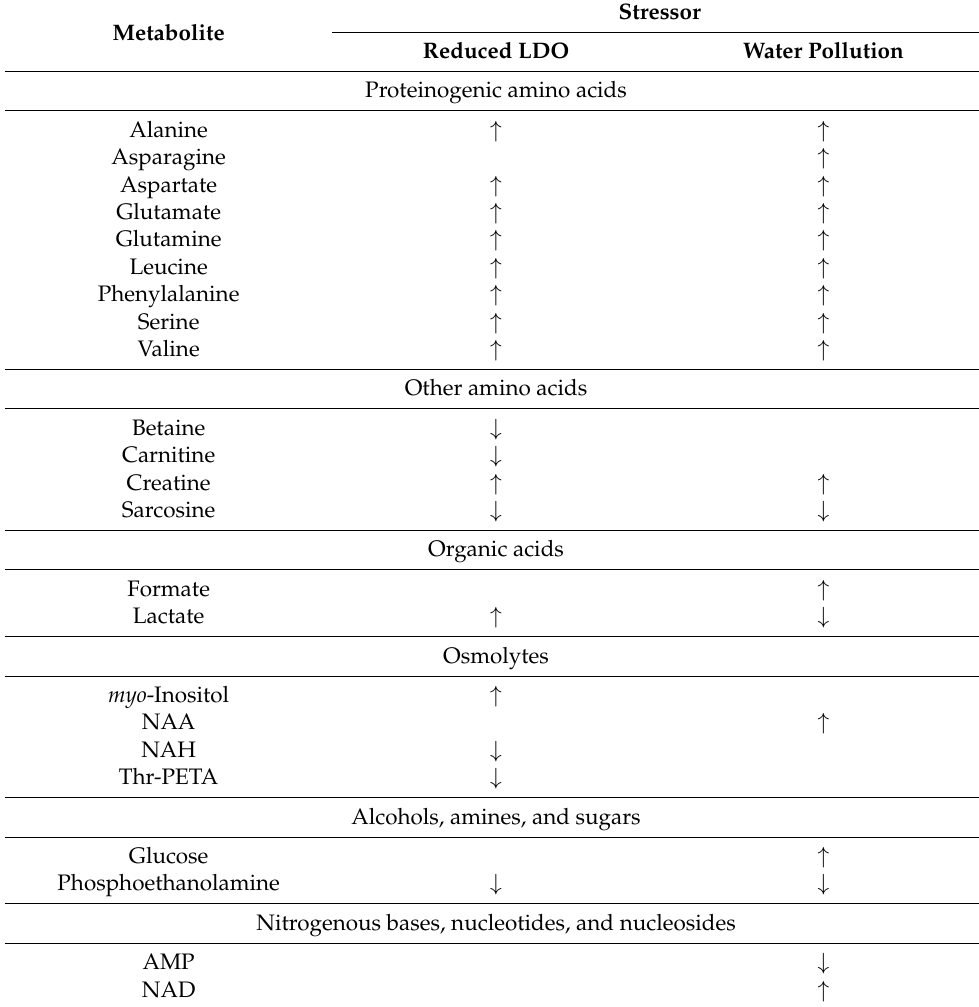
Table 3. Changes in the metabolite concentrations in lenses of freshwater fish under influences of reduced LDO and anthropogenic water pollution caused by CO 2 emissions. Arrows indicate the direction of